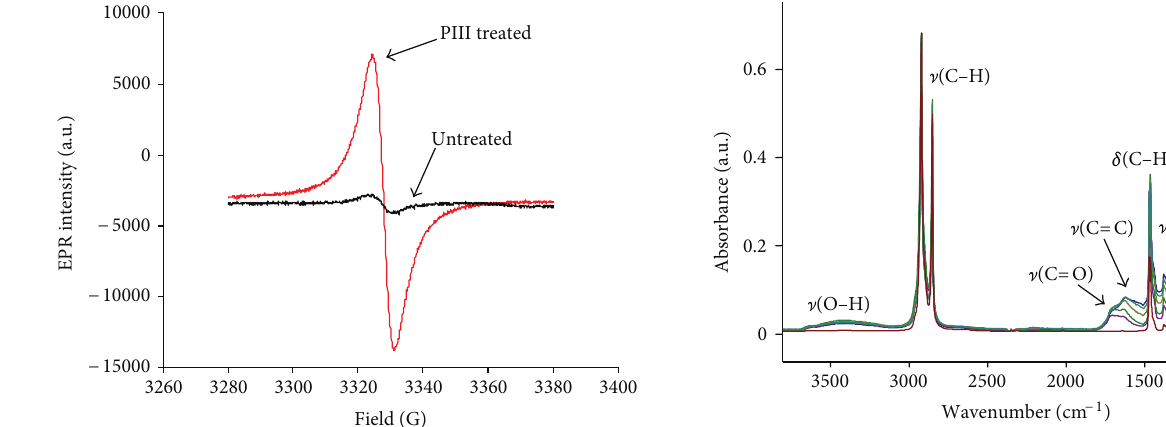
F 4: ESR spectra of LDPE �lm before and aer PIII treatment. PIII treatment was done with 20keV energy nitrogen ions to an ion �uence of 2 . e spectrum of the treated polyethylene surface was recorded aer 30 minutes of exposure to